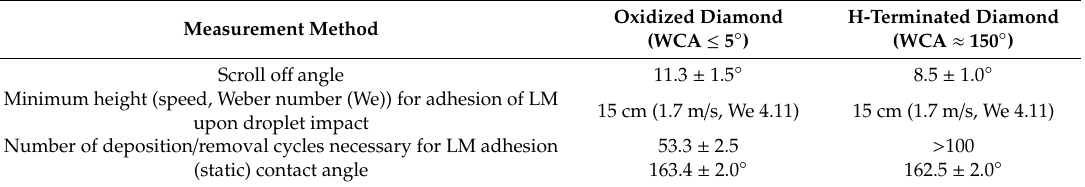
Table 1. Comparison of the roll-o ff angle, static contact angle, and number of deposition cycles for adhesion of the LM on hydrophilic and hydrophobic rough diamond coatings on Ti